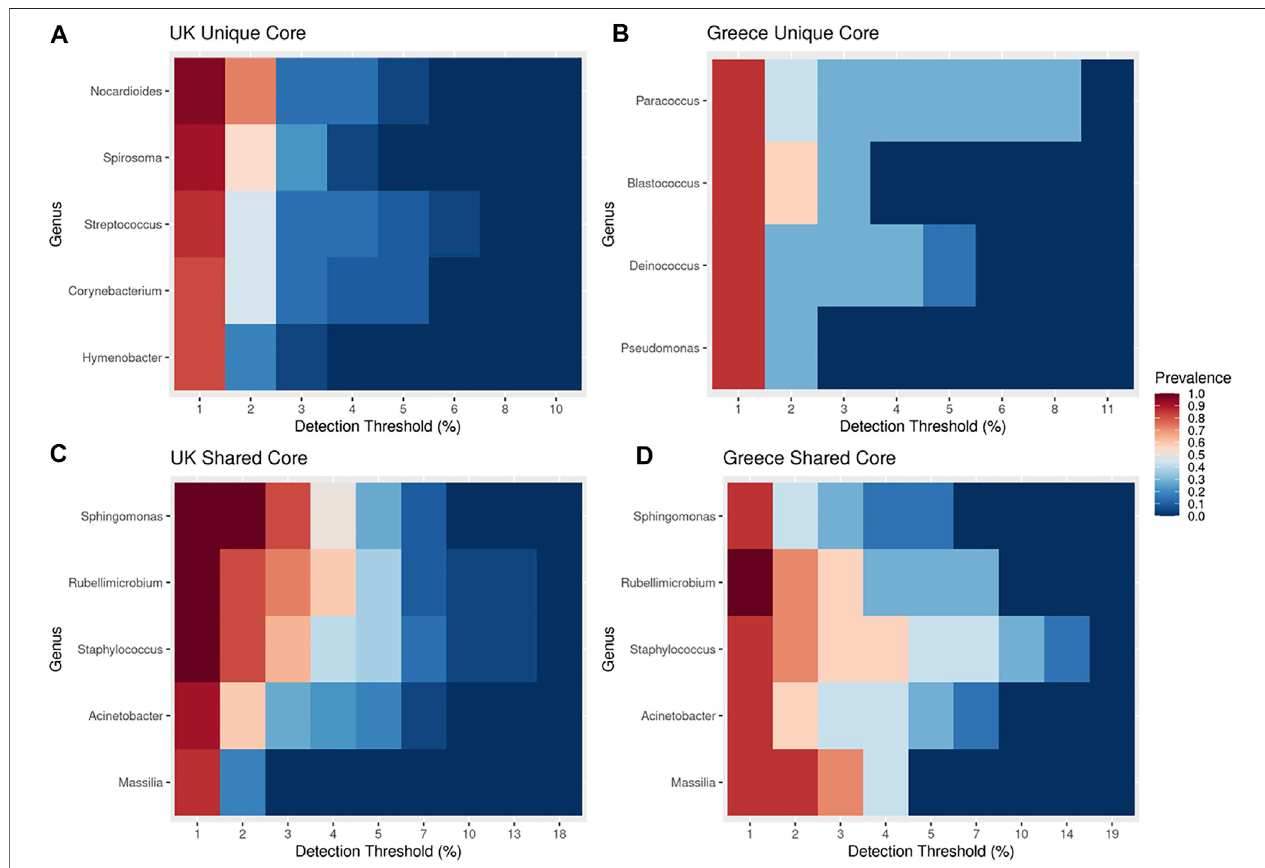
FIGURE 3 | A core microbiome analysis covering unique and shared taxa for each location based upon a robust 75% prevalence threshold with at least 1% detection threshold. (A) UK unique core microbiome (B) Greece unique core microbiome, (C) UK shared core microbiome, (D) Greece shared core microbiome.